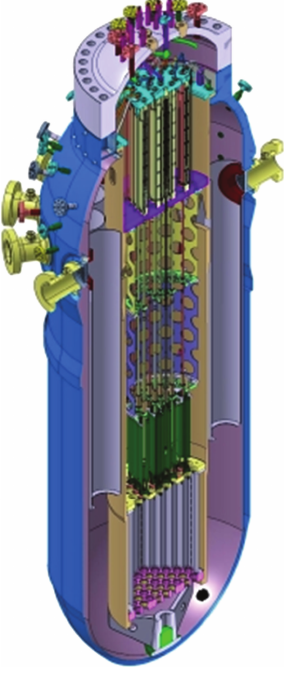
Figure 1: Reactor pressure